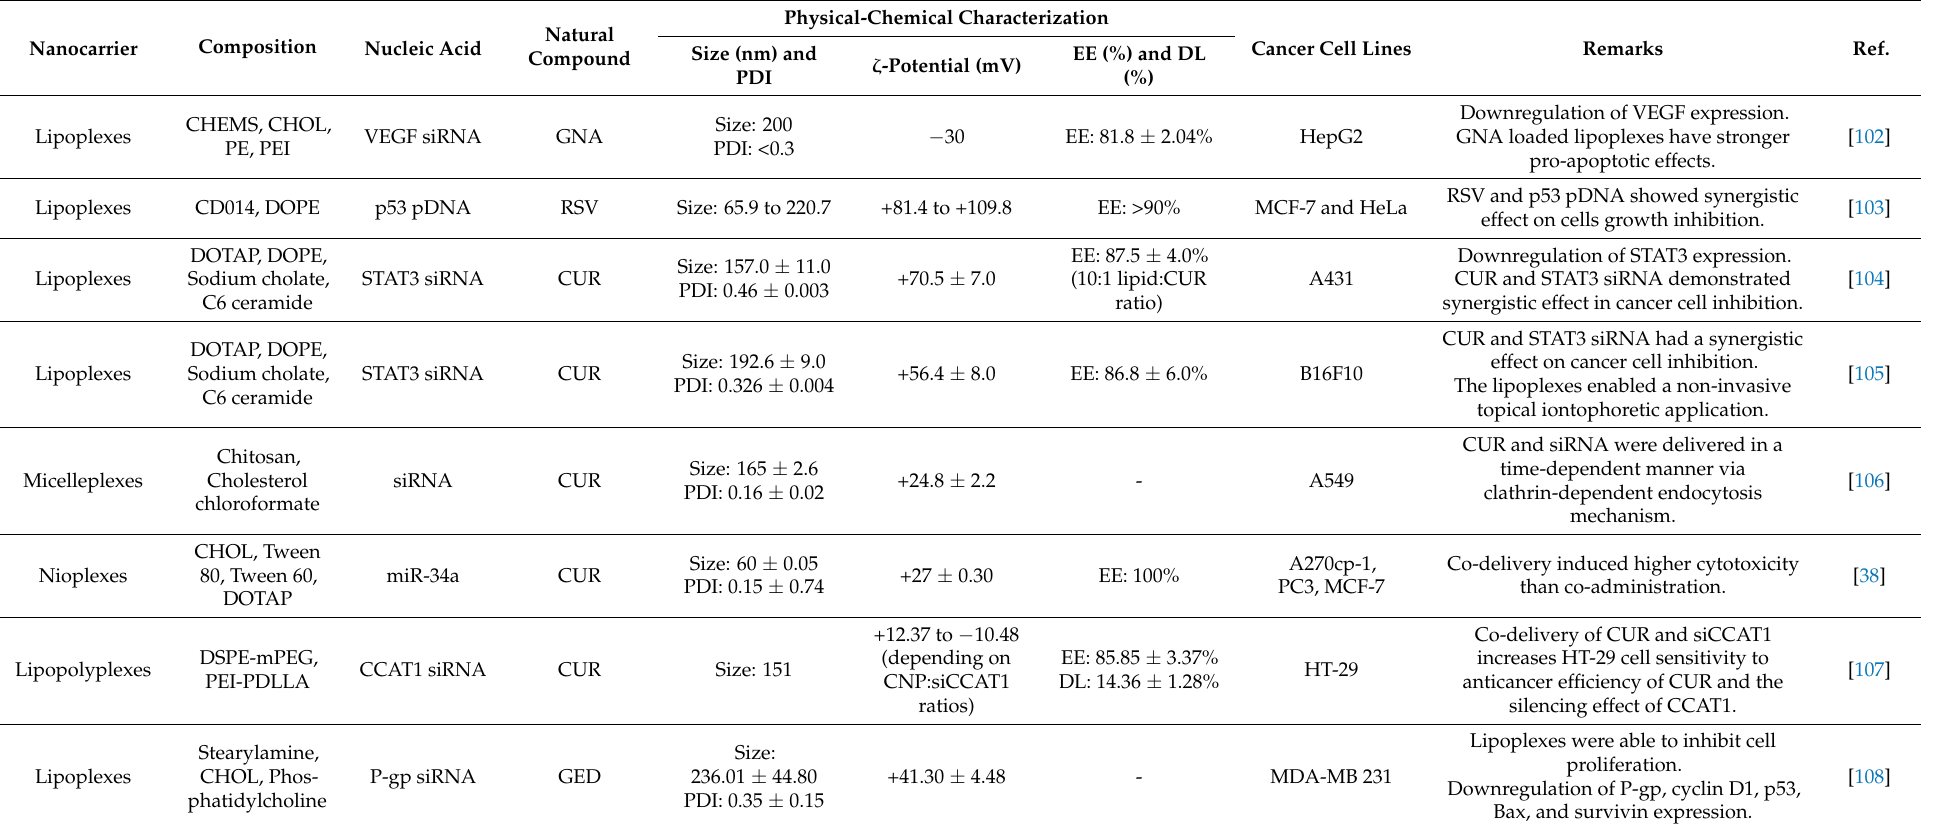
Table abbreviations: A270cp-1-Human ovarian cancer cells; A431-Human skin carcinoma cells; A549-Human lung adenocarcinoma cells; B16F10-Murine melanoma cells; CCAT1- Colon cancer-associated transcript-1; CD014-Peptide-cationic lipid; CHEMS-Cholesteryl hemisuccinate; CHOL-Cholesterol; CUR-Curcumin; D.L.-Drug loading;